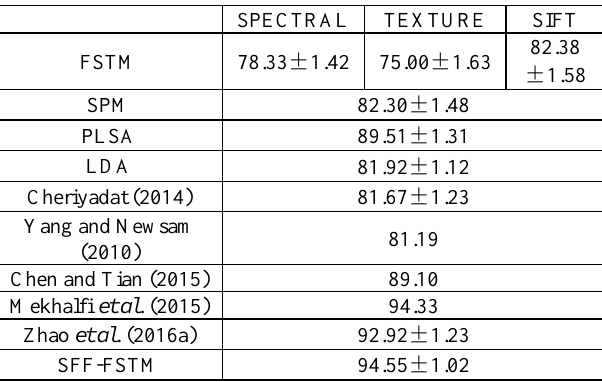
Table 2. Classification accuracies (%) of different strategies based on the FSTM and comparison with the experimental results of previous methods for the UC Merced dataset